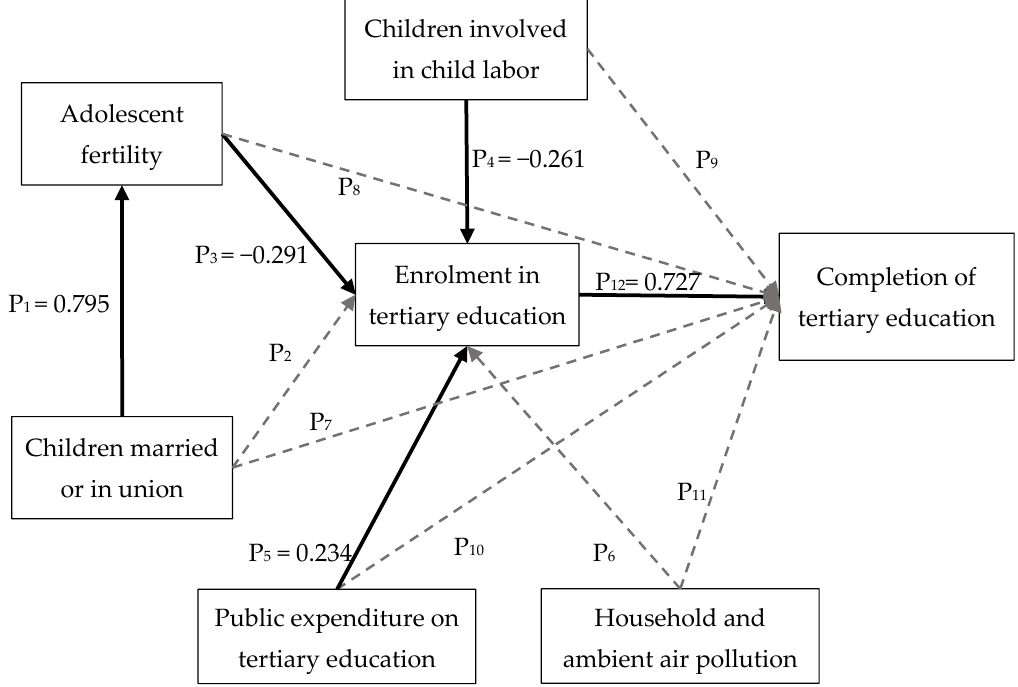
Figure 3. An exemplary socio ‐ economic relation model including the presumed pathways between the six selected criteria and the criterion completion of tertiary education and the strength of the valid relation.